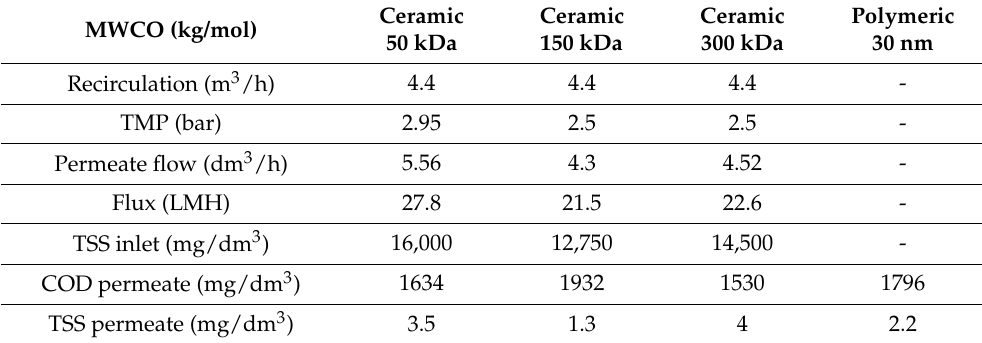
Table 4. Results from different MWCO in a small industrial pilot unit.